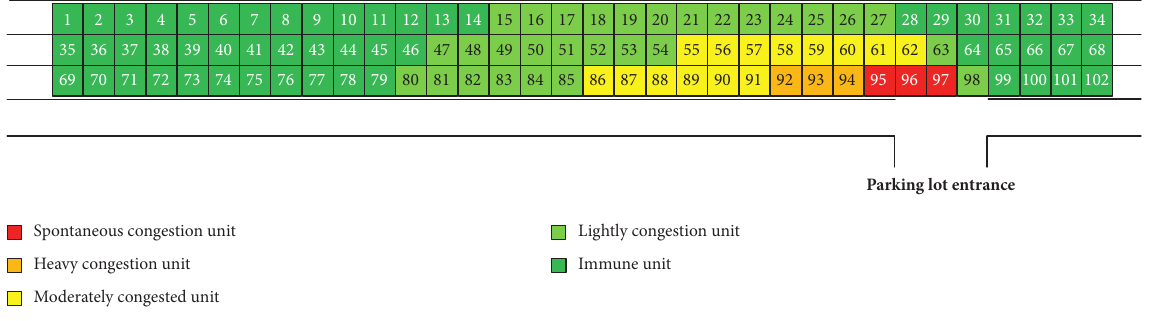
Figure 4: Distribution of the spatial unit.